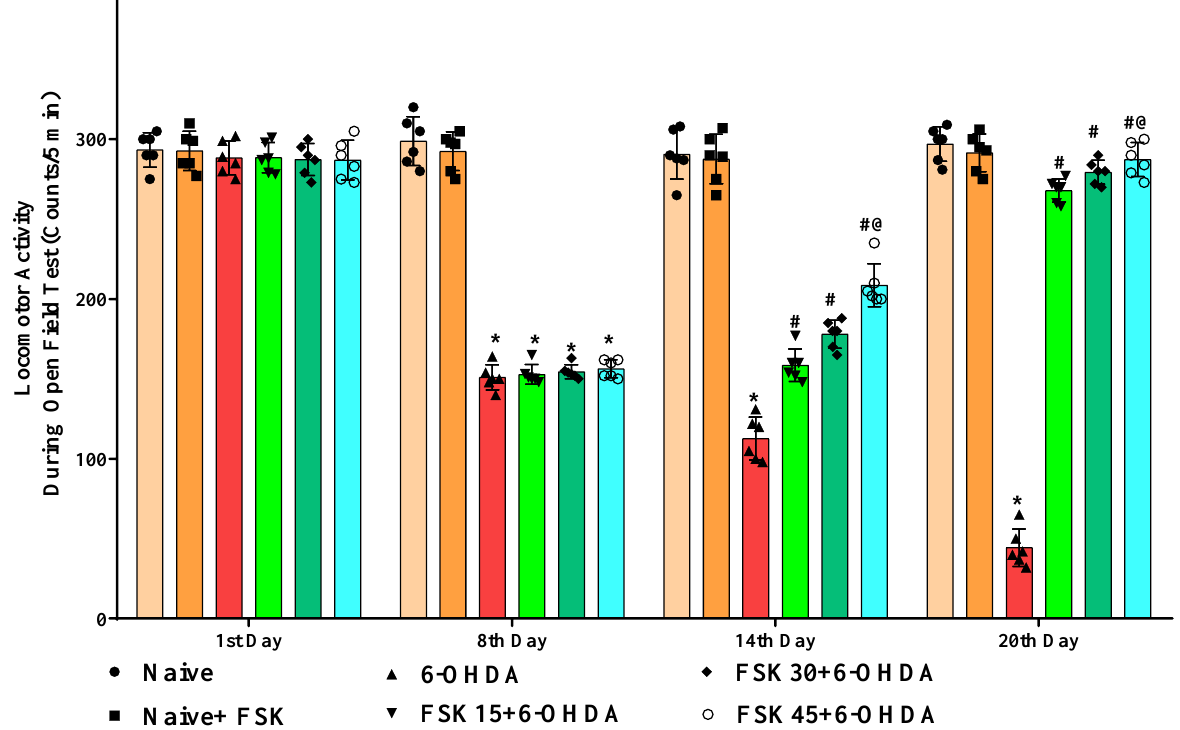
Figure 5. FSK improved locomotion using the open-field test in the experimental model of PD. Data provided as mean ± SD (n = 6) followed by ANOVA (two-way) with post-hoc Bonferroni test. * 6-OHDA ( p < 0.01) compared with naive and naive + FSK . # FSK15, FSK30, FSK45 (p < 0.01) com- pared with 6-OHDA ; #@ FSK45 (p < 0.01) compared with FSK30, FSK15 . 6-OHDA ; #@ FSK45 (p < 0.01 ) compared with FSK30, FSK15